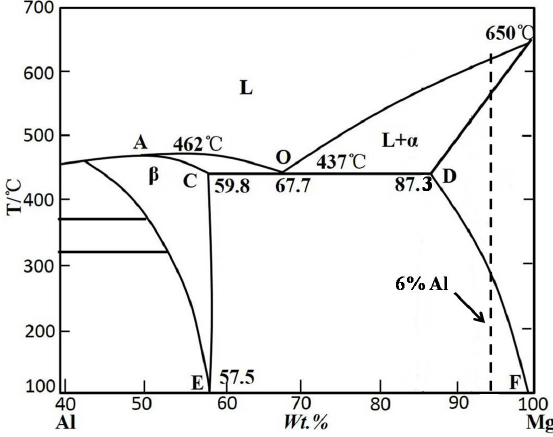
Figure 1. Phase diagram of AM60 alloy.